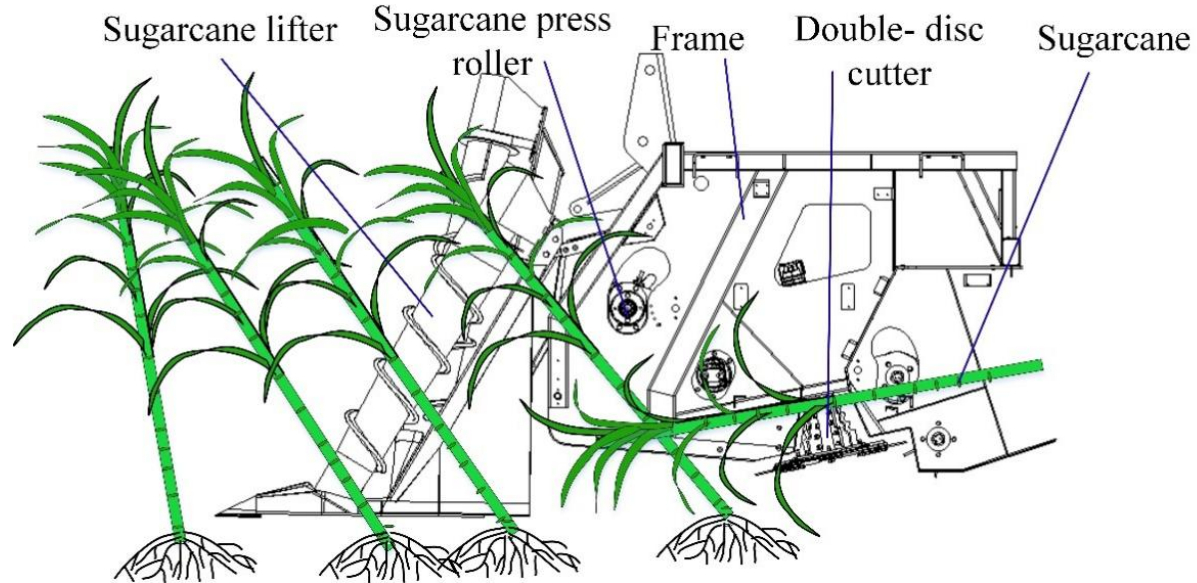
Figure 2. Composition structure and operation principle of the SLS.